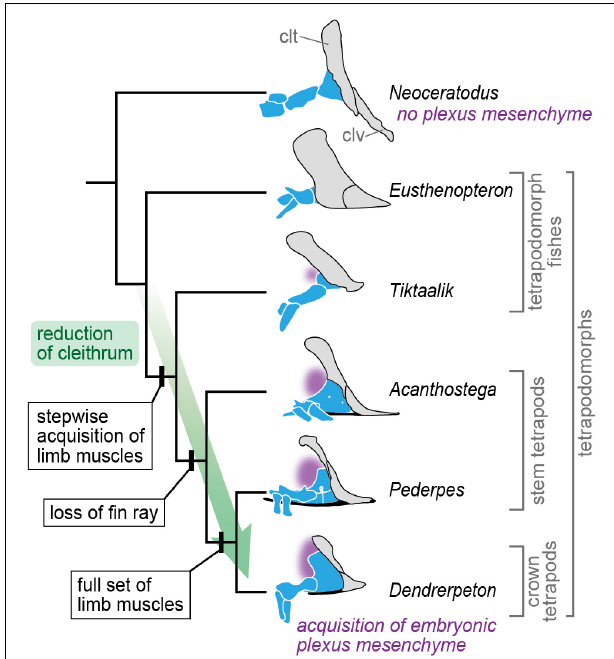
FIGURE 5 | A scenario for evolution of the plexus mesenchyme. In the evolution leading to the crown tetrapods, the cleithrum gradually became reduced, and concurrently, the full set of limb muscles was acquired in a stepwise manner (Molnar et al., 2017). At this transitional phase, the brachial plexus might become evolutionarily fixed, being accompanied with an acquisition of the embryonic plexus mesenchyme, which replaced the cleithrum-forming embryonic domain. The cleithrum and clavicle are gray, endoskeletal shoulder girdle and limb skeleton blue, interclavicle black, and position of the plexus mesenchyme (in embryonic development) purple. Abbreviations: clt, cleithrum; clv, clavicle. The tetrapodomorph skeletons are redrawn from Andrews and Westoll (1970), Coates (1996), Clack and Finney (2005), Shubin et al. (2006), and Clack